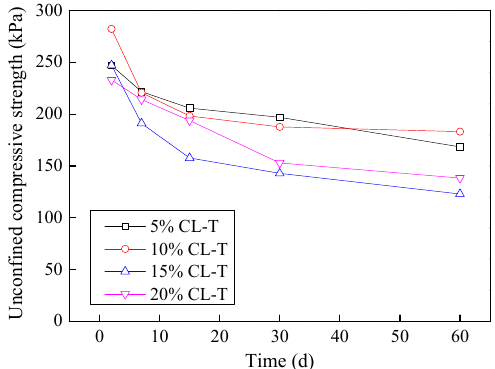
Figure 16. Effects of tannery effluent on the cohesion of CL soil samples.